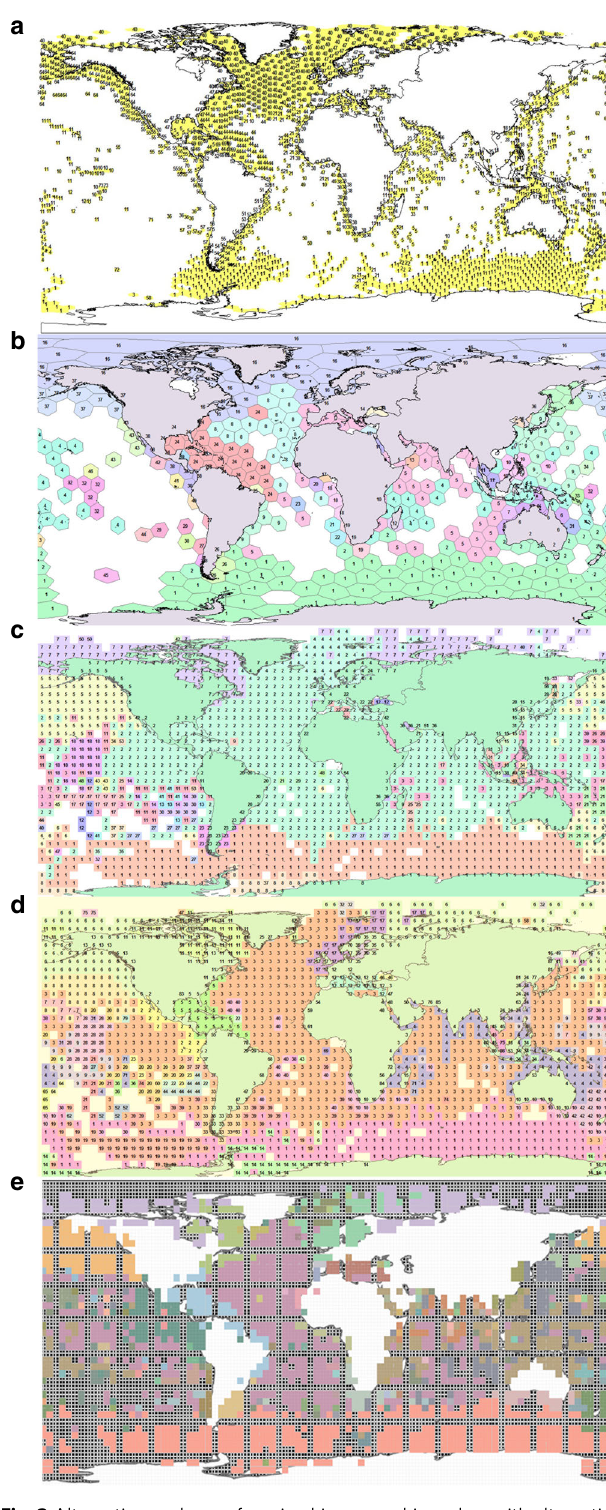
Fig. 3 Alternative analyses of marine biogeographic realms with alternative dissimilarity metrics and cell sizes. a – c Used Beta SIM index and d Sorensen ’ s index of dissimilarity. a , b Used 50,000km 2 and 600,000 km 2 hexagons, respectively. c , d Used 5° latitude-longitude cells. e